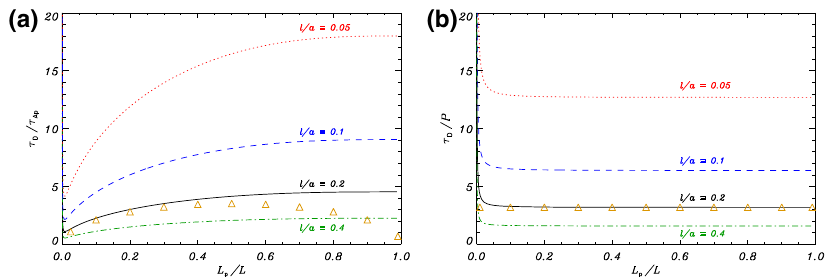
Fig.81 Resultsforathreadconfigurationwithatransversetransitionallayerandfortheprominencethread located at the central part of the magnetic tube. a τ d in units of the internal Alfvén travel time, τ Ap , and b / P as a function of L p / L . The different lines in both panels denote l / a = 0.05 (dotted), 0.1 (dashed), 0.2 τ d (solid) and 0.4 (dash-dotted). The symbols in ( a ) and ( b ) correspond to the analytic approximations with l / a = 0.2, Eqs. (34) and (32) in Soler et al. (2010a). Image reproduced with permission, copyright by